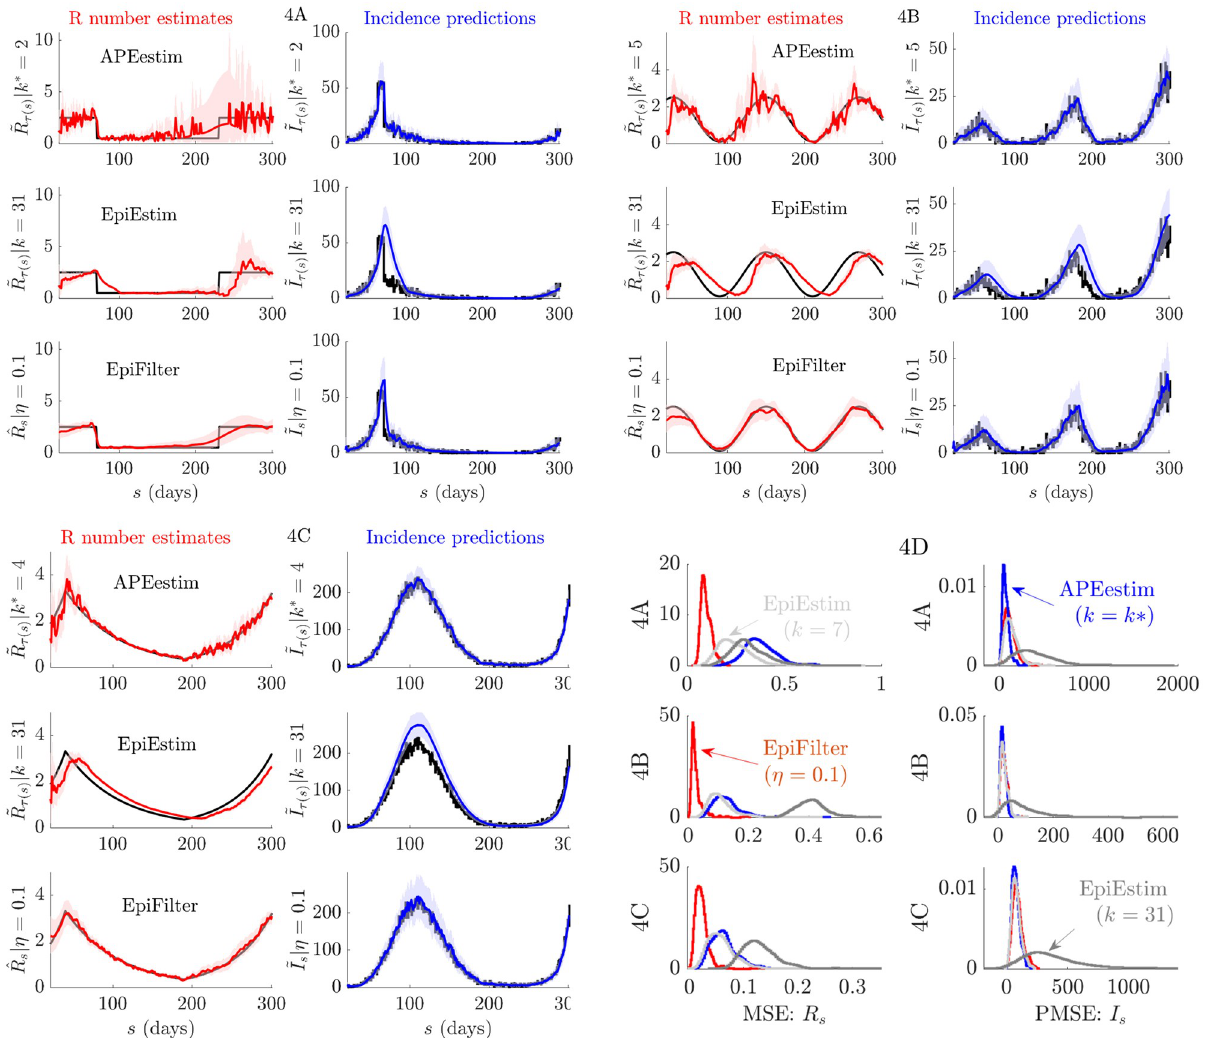
Fig 4. Epidemics with multiple waves. We compare reproduction number estimates ( ~ R from APEestim with optimal window k � , EpiEstim with window k and EpiFilter with state noise η . We simulate 200 epidemics with multiple waves of infection using the standard renewal model (Eq (1)) for three scenarios, representative examples of which are given in A-C. The true R black. All mean estimates or predictions are in red and blue with 95% equal tailed credible intervals. APEestim and EpiEstim use a Gam(1, 2) prior distribution and EpiFilter a grid with m = 2000, R min = 0.01 and R max = 10. In D we provide statistics of the MSE of these estimates (relative to R s ) and ) for all 200 runs. We find EpiFilter is best able to negotiate troughs between epidemic peaks and hence infer the PMSE of these predictions (relative to I s resurging infectious dynamics, achieving significantly smaller MSE (2–10 fold reductions) and comparable PMSE to APEestim (which is optimised for